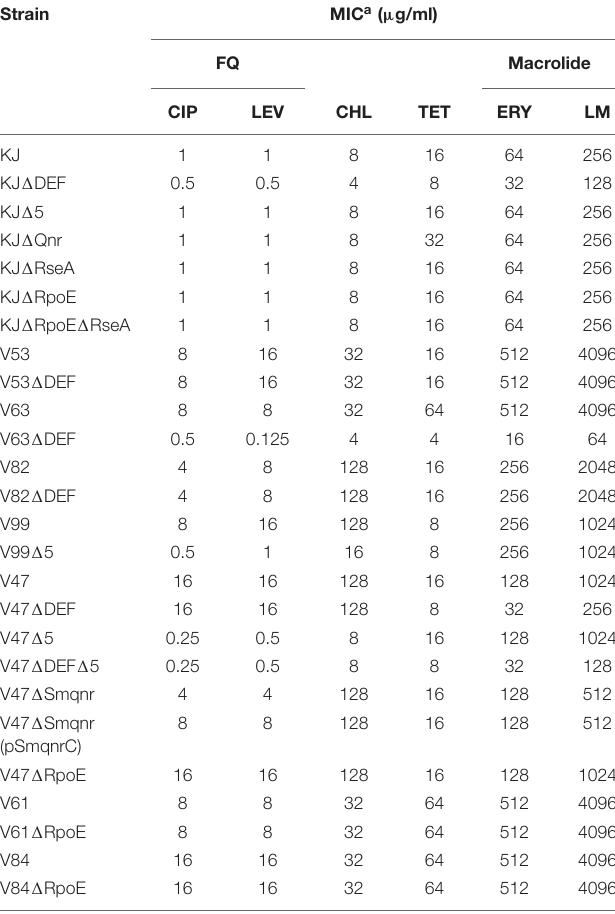
TABLE 2 | Antibiotic susceptibilities of clinical isolates and their derived